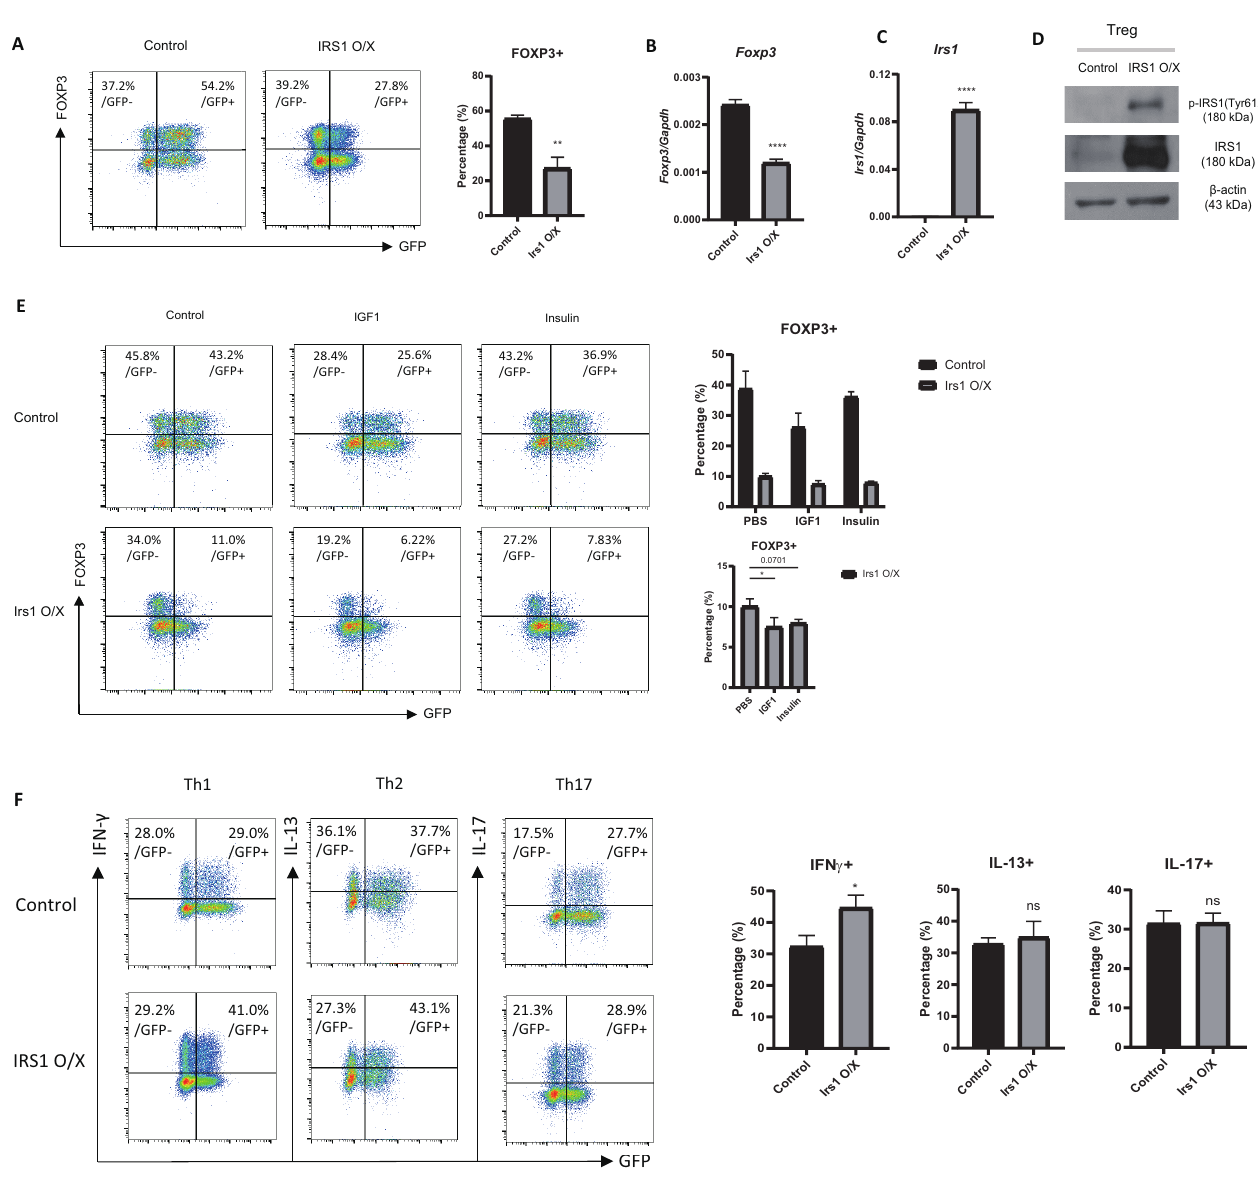
Figure 2. Overexpression of IRS1 reduces Treg cell differentiation. ( A – E ) Naïve CD4 T cells isolated from C57BL/6J mice were cultured for 1 day under Th0 conditions and then transduced with the MIEG3-IRS1 vector. After transduction, cells were cultured for 2 days under Treg-inducing conditions. ( A ) FOXP3 protein levels were measured via flow cytometry. ( B – D ) GFP+ cells, sorted using a flow cytometer, were used. ( B ) Irs1 and Foxp3 mRNA levels were measured via qRT-PCR. ( D ) Y612- phosphorylated form and whole protein of IRS1 were measured via Western blot analysis. β -actin was used as an internal control. ( E ) After transduction, PBS or IGF1 (100 ng/mL) or insulin (100 ng/mL) were treated and cultured for 2 days under Treg conditions. FOXP3 expression was measured via flow cytometry. ( F ) Naïve CD4 T cells were transduced with the MIEG3-IRS1 vector (as in ( A )). The cells were then differentiated into each subset for 2 days. IFN- γ , IL-13, and IL-17 proteins were measured via flow cytometry. Expression was measured via qRT-PCR and normalized to that of Gapdh . All data are representative of three independent experiments. The bar graph next to the flow cytometry plot shows data pooled from three independent experiments. The error bars represent the SD, and ( A – C , F ) p -values were calculated using a t -test. ( E ) p -value of the bottom graph was calculated using one-way ANOVA/Tukey test. * p < 0.05, ** p < 0.01, **** p < 0.0001. ns: not